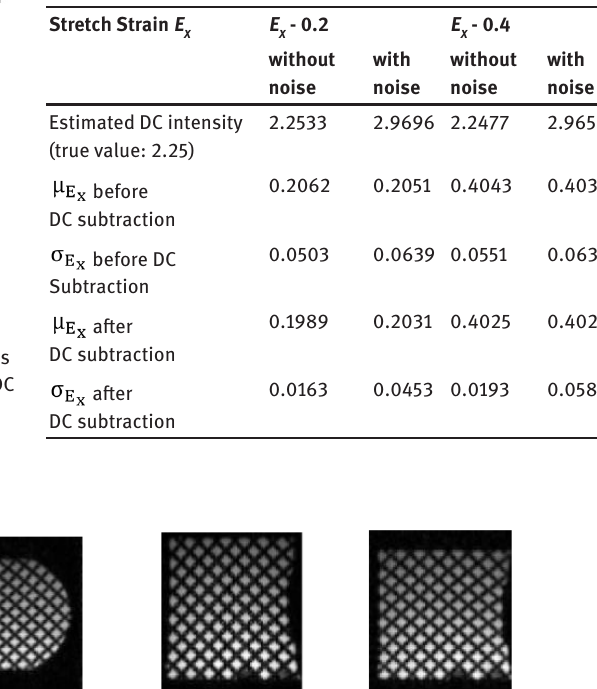
Table 1: Estimated dc intensity and calculated